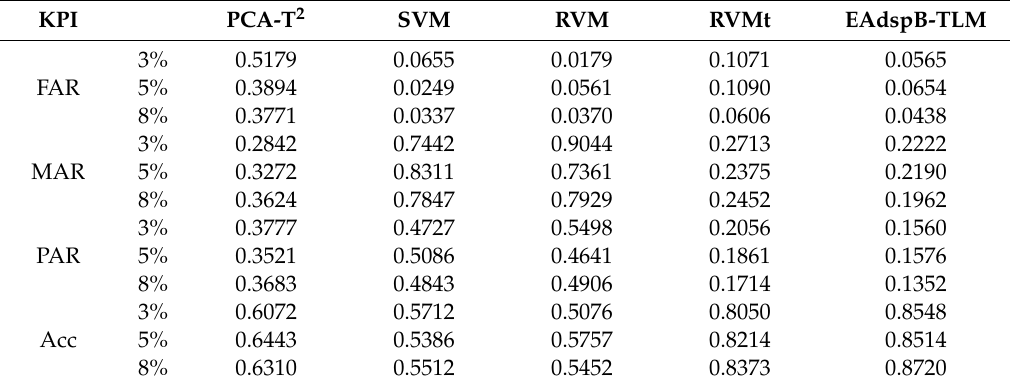
Table 2. Monitoring results for Fault